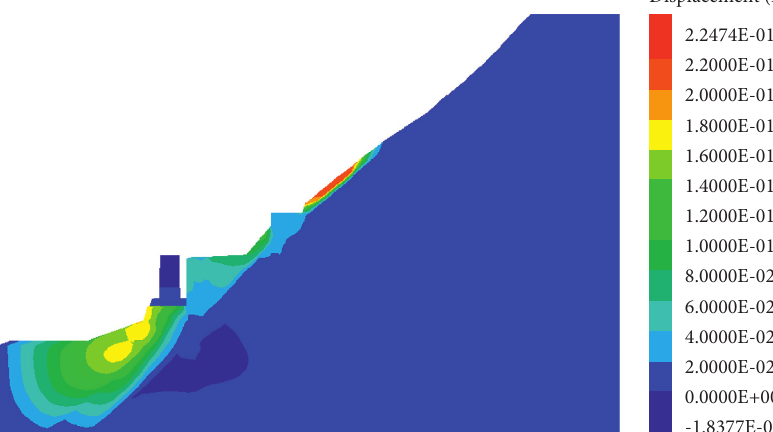
Figure 17: Cloud diagram of bending moment of bridge pile